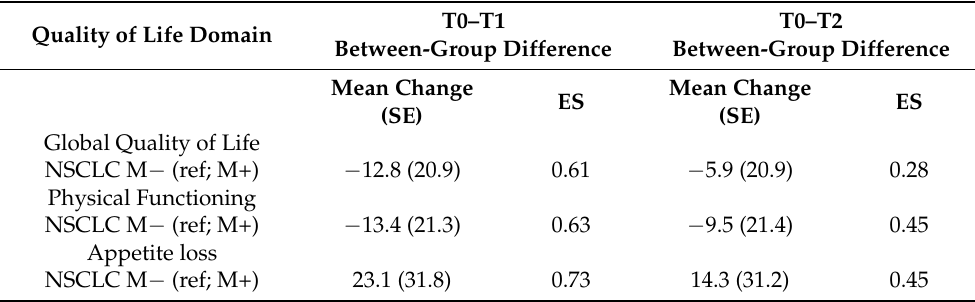
Scores are presented as mean change scores from baseline between groups, with NSCLC M+ as reference group. Abbreviations: T0, baseline; T1, 15 weeks; T2, 6 months; SE, standard error; ES, effect size; NSCLC, non-small cell Table 4. Mortality rates.